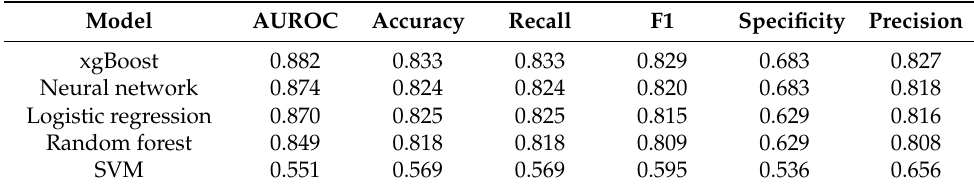
Table 3. Performance of different machine models on the testing dataset.